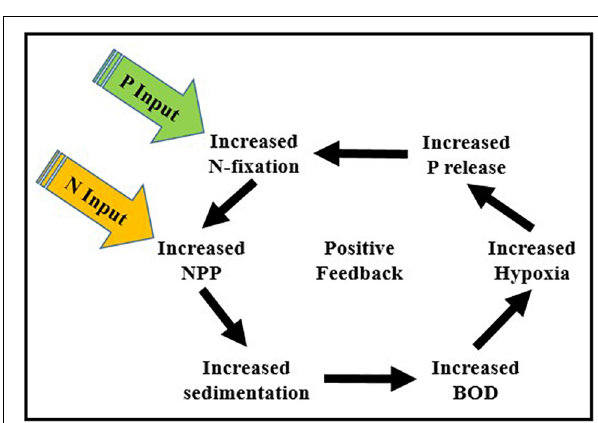
FIGURE 6 | The positive feedback between anthropogenic inputs of N and P, N-fixation by cyanobacteria, increases in NPP, and oxygen depletion driven by the release of P from benthic sediments under low oxygen conditions (NPP, net phytoplankton production; BOD, biological oxygen demand).